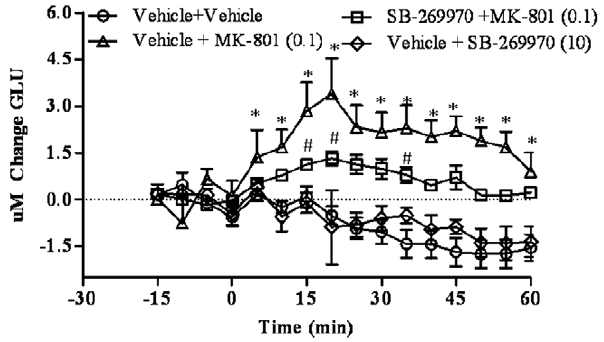
Figure 3. Effects of SB-269970 on MK-801-induced glutamate efflux in the prefrontal cortex. Real-time measurements of glutamate were conducted before and after compound administration. Results are expressed as as mean 6 S.E.M of change in glutamate concentrations (N=5–15 per group). SB-269970(10 mg/kg) did not affect glutamate levels per se but attenuated MK-801(0.1 mg/kg)- induced increases in glutamate efflux. *p , 0.05, at each time point comparing vehicle + MK-801 to vehicle + vehicle. # p , 0.05, at each time point comparing SB-269970 + MK-801 to vehicle + MK-801.